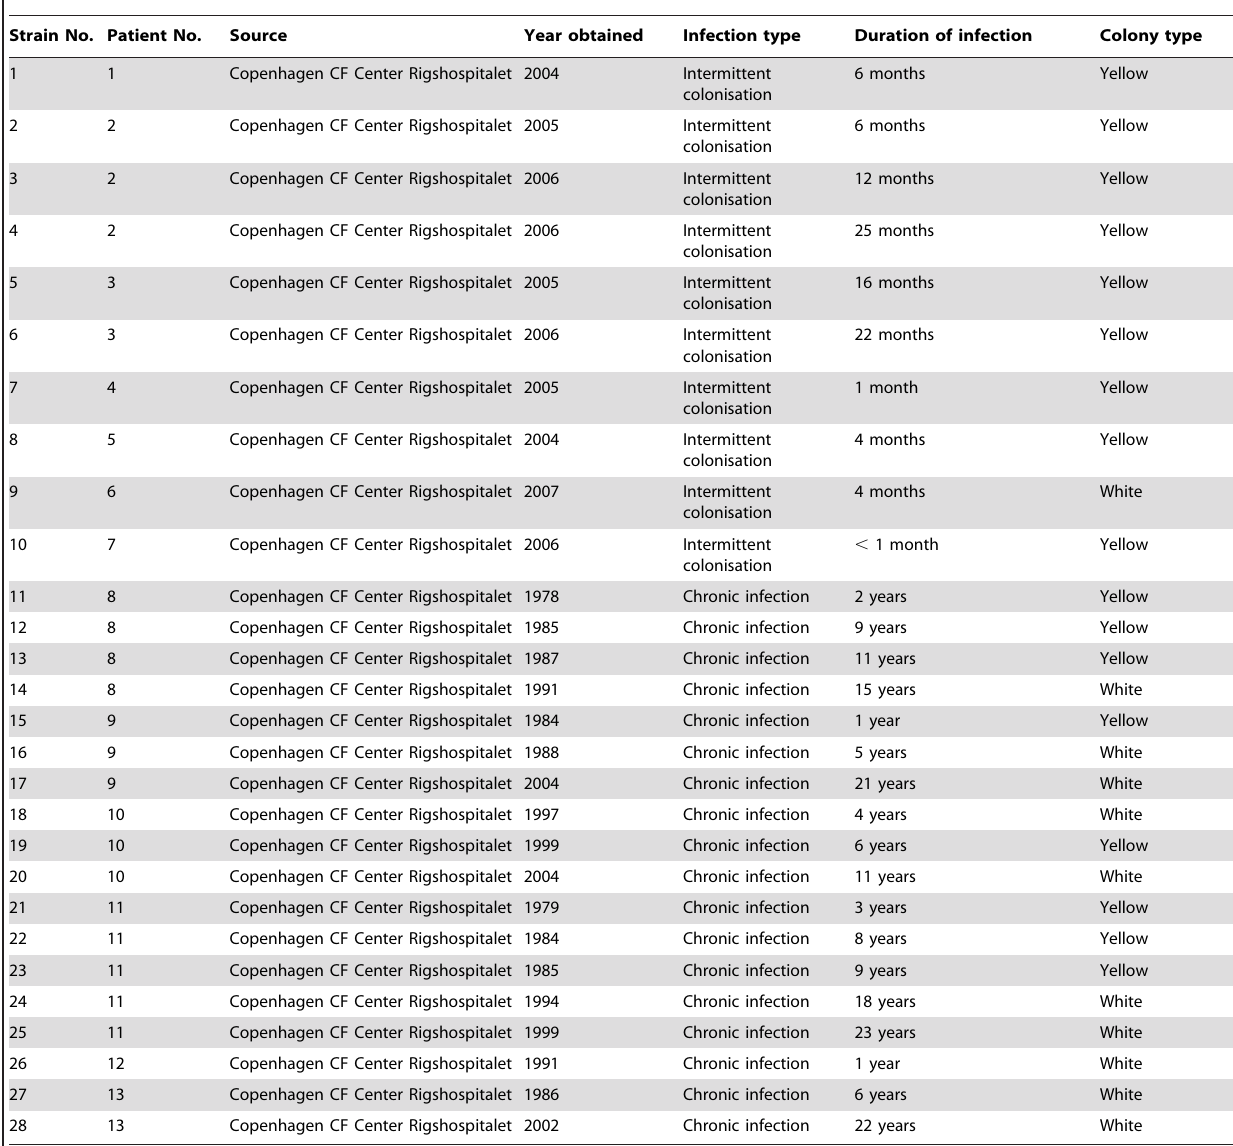
Table 1. Bacterial strains used in this study.